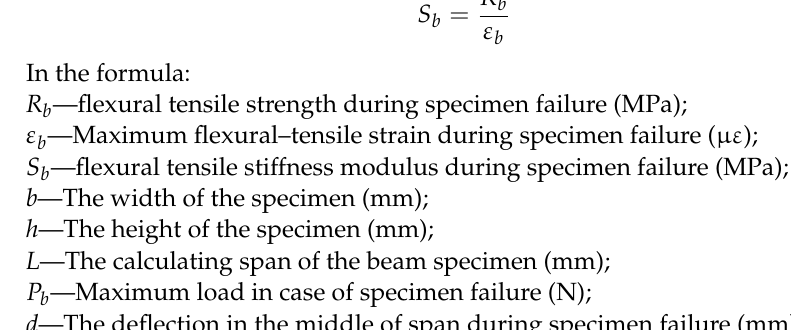
Table 5. Record table of compressive strength test results of cube specimens at standard tempera-